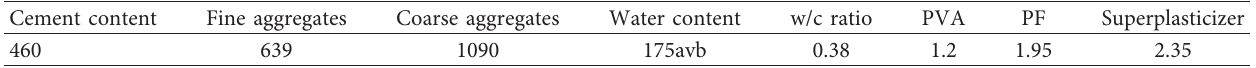
Table 1: HFRC mix design (kg/m 3 ).